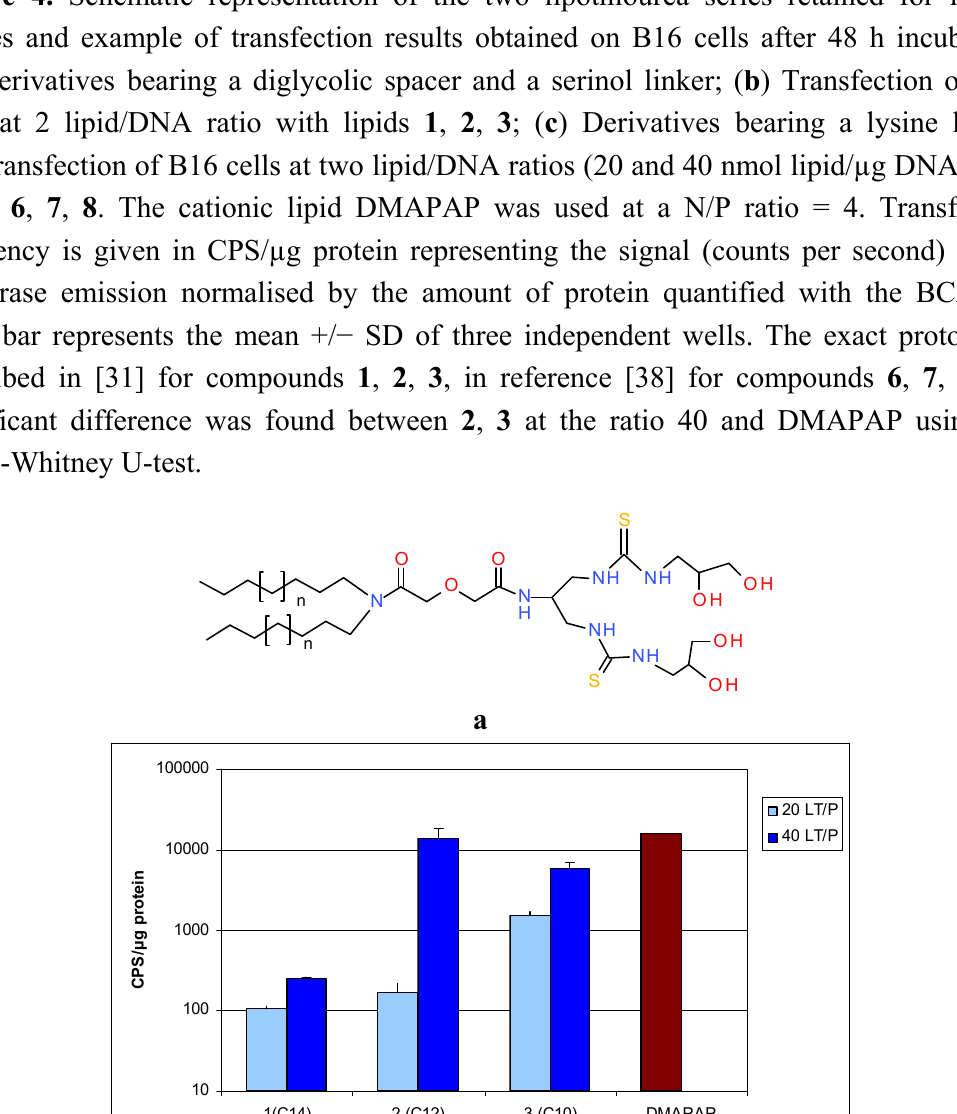
Figure 4. Schematic representation of the two lipothiourea series retained for further studies and example of transfection results obtained on B16 cells after 48 h